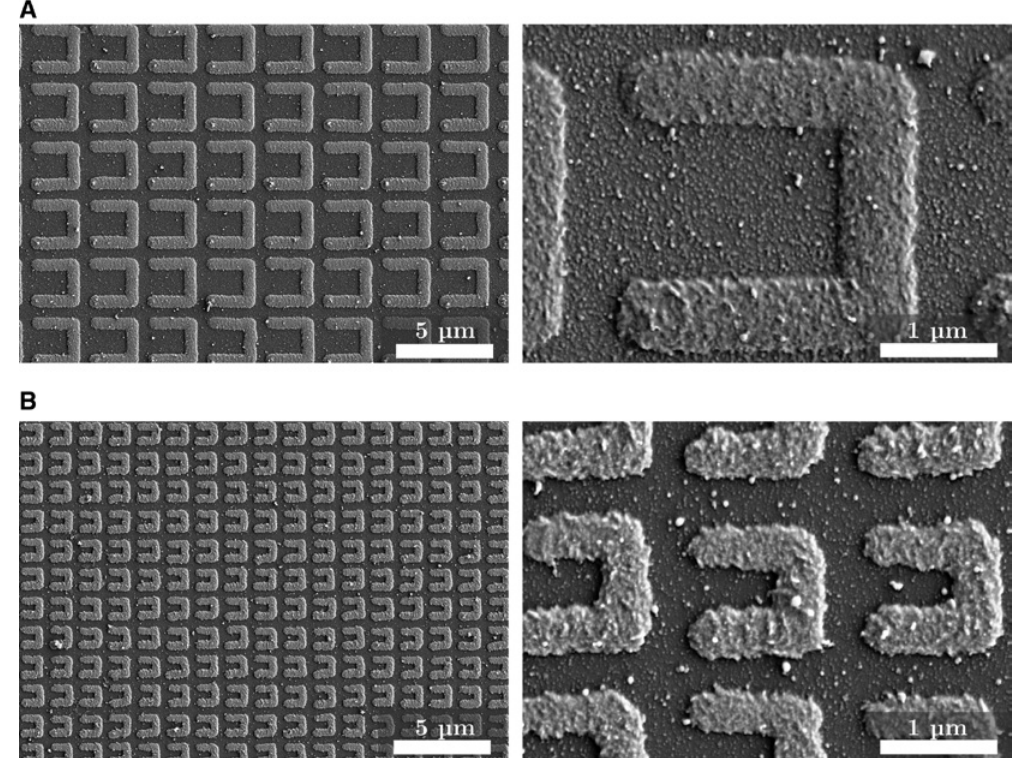
Figure 8: Silver split-ring resonator arrays. Overview and close-up of silver split-ring resonator arrays with (A) arm lengths of 1.9 μ m and a separation of 3 μ m and (B) arm lengths of 0.8 μ m and separation of 1.5 μ m.